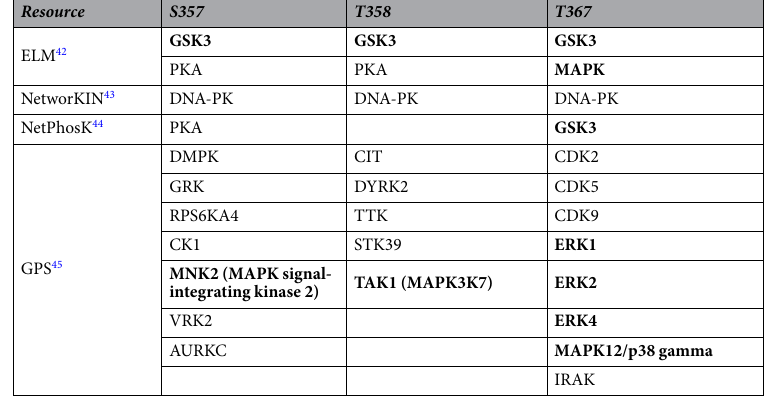
Table 1. Kinase predictions of the phosphorylated residues S357, T358 and T367. Kinases involved in the MAPK pathway or p38 substrates are bolded and kinases involved in DDR are marked in